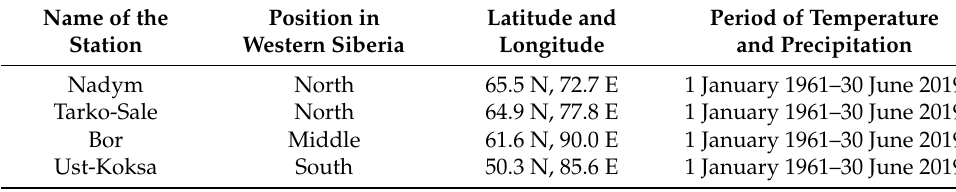
Table 2. Meteorological data used for calculating extreme indices [10].